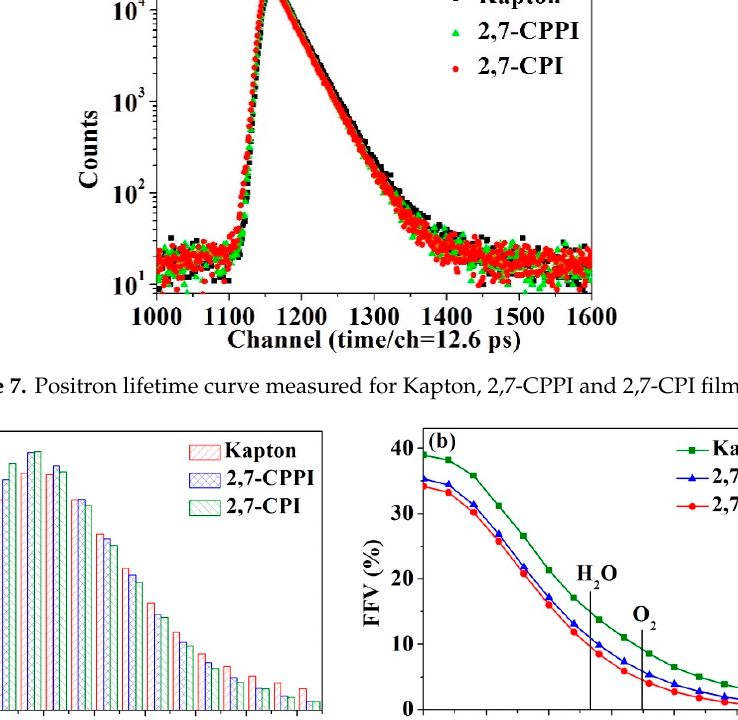
Figure 8. Distributions of void radius ( a ) and fractional free volume ( b ) as a function of probe radius in Kapton, 2,7 ‐ CPPI and 2,7 ‐ CPI. The kinetic radii of O 2 and H 2 O are indicated by vertical lines.